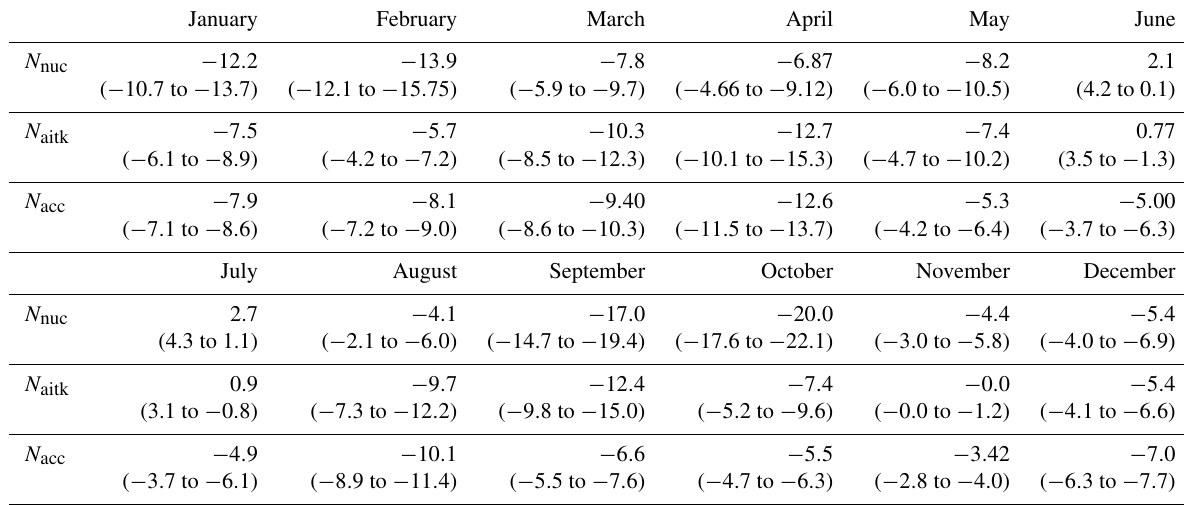
Table 4. Theil–Sen estimator trend slopes (cm − 3 yr − 1 ) and upper and lower confidence intervals for monthly inter-annual trends in modal number concentration 2000–2017.